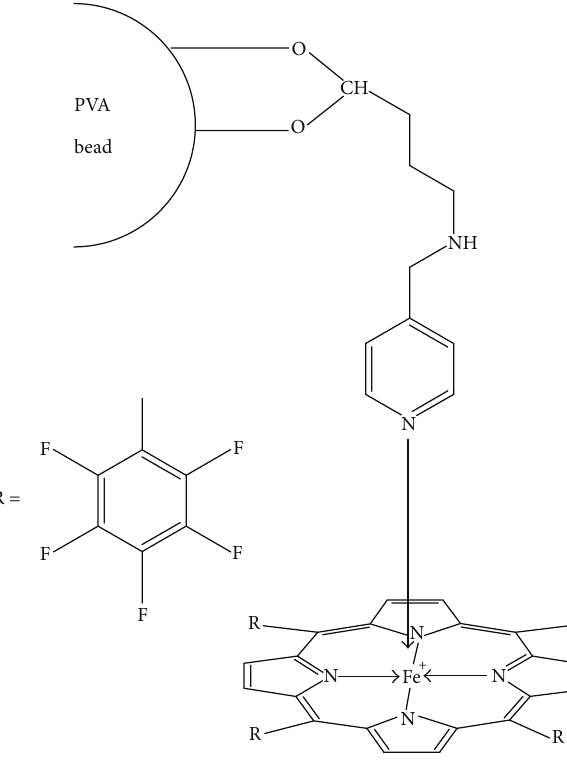
Figure 1: Proposed structure of the catalytic adduct PP-PVA/